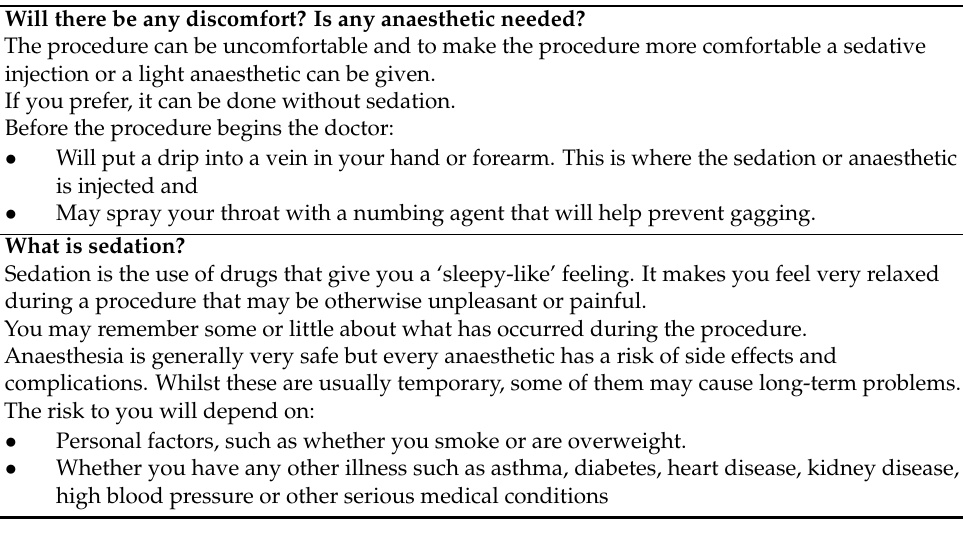
Table 1. Queensland Health “Consent Information” information sheet—paragraph educating patients about sedation. Permission to publish obtained from Queensland